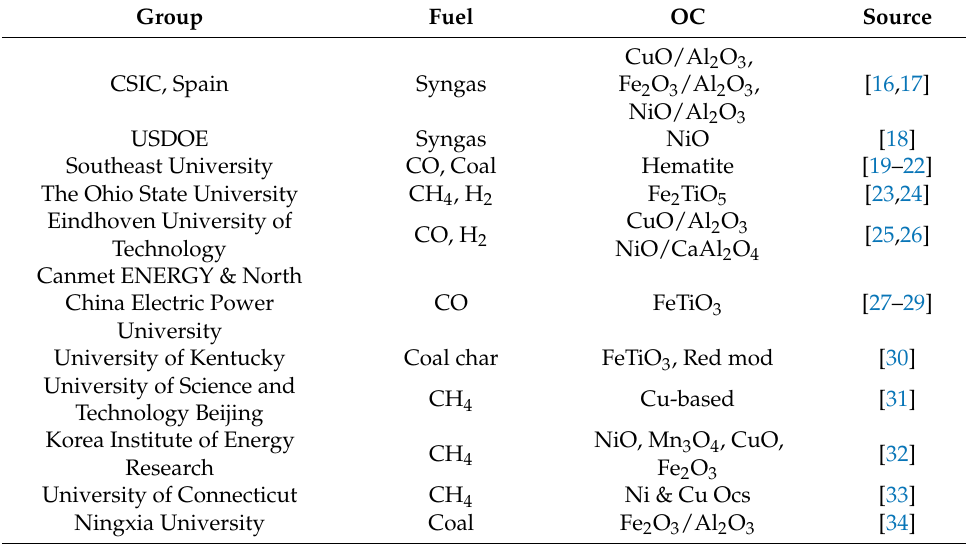
Table 1. Pressurized TGA (PTGA) tests on oxygen carriers [15].